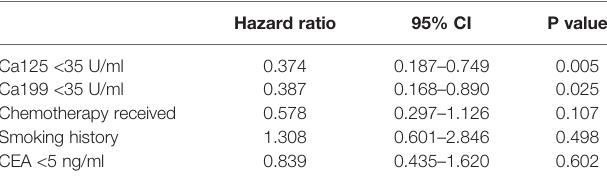
TABLE 3 | Multiple analysis of OS in PASC patients.